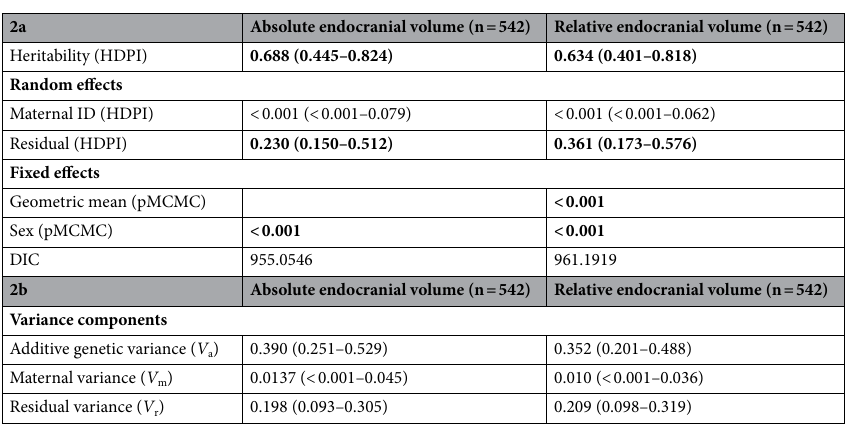
Table 2. ( 2a ) Heritability results for absolute endocranial volume and relative endocranial volume (n = 300 females, n = 242 males). Heritability and random effects with a highest distribution posterior interval (HDPI) of 0.3 or greater and fixed effects with a pMCMC value of < 0.05 are bolded. ( 2b ) Posterior means of each variance component for endocranial volume with 95% credible intervals (CI) in parentheses.